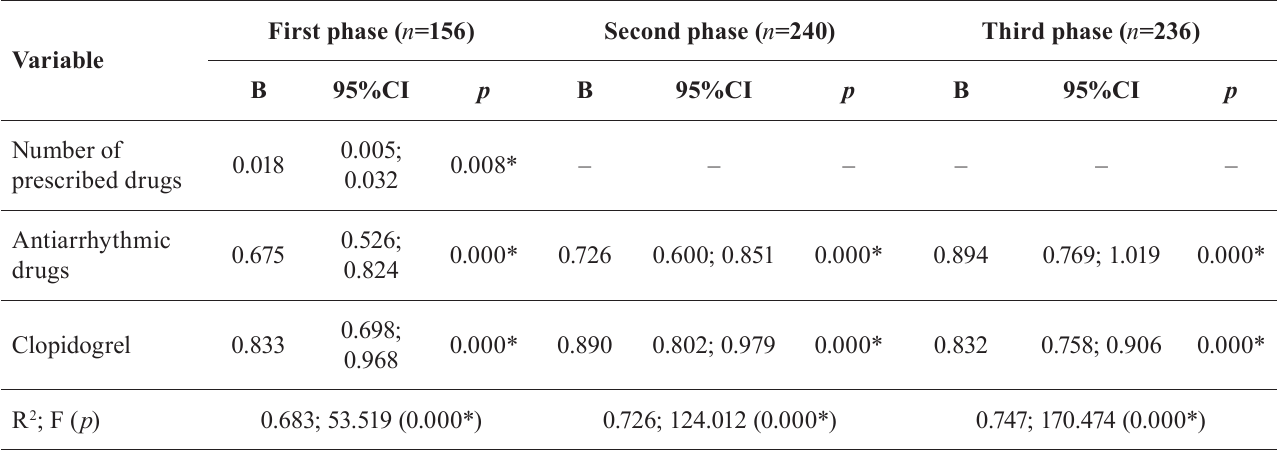
TABLE IV - Risk factors for statin potential drug-drug interactions in acute coronary syndrome patients across phases of